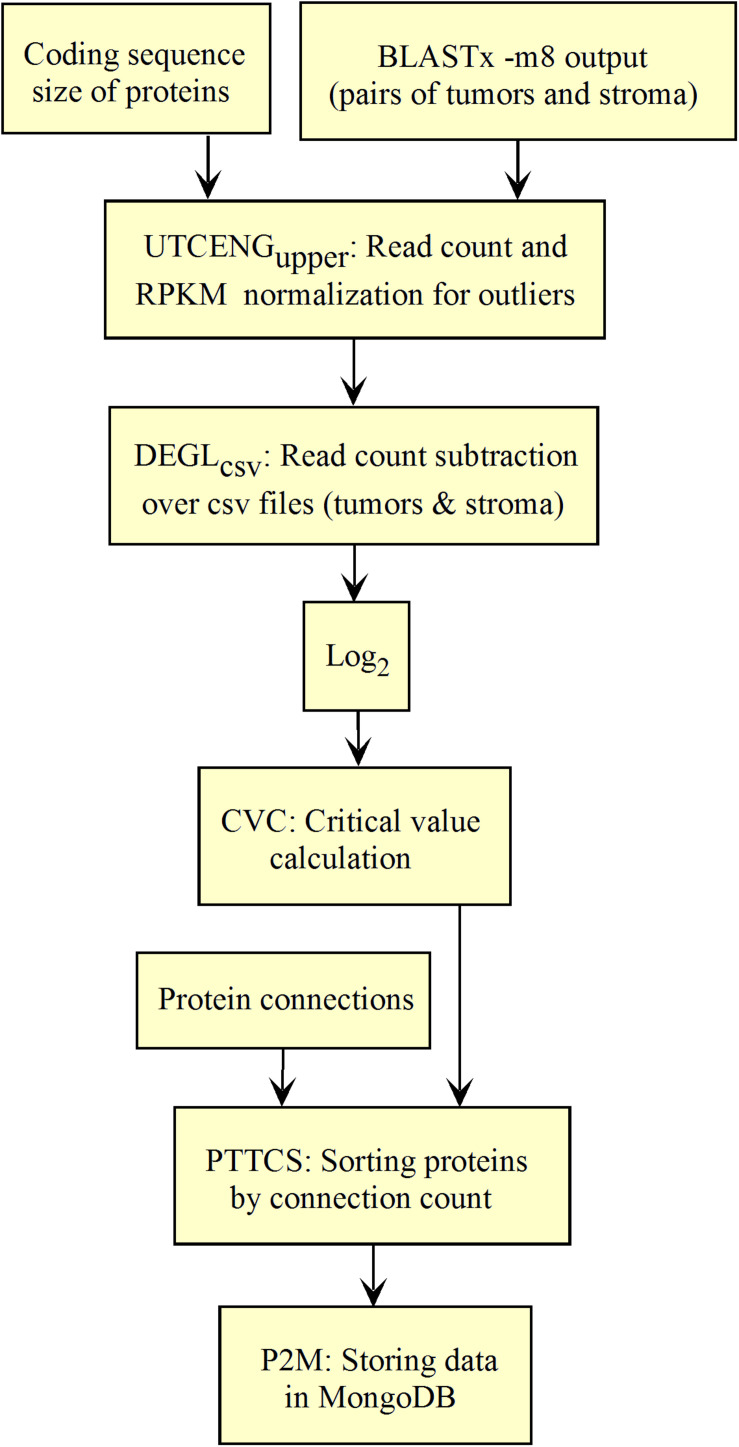
Workflow for collections of BLASTx output processing.